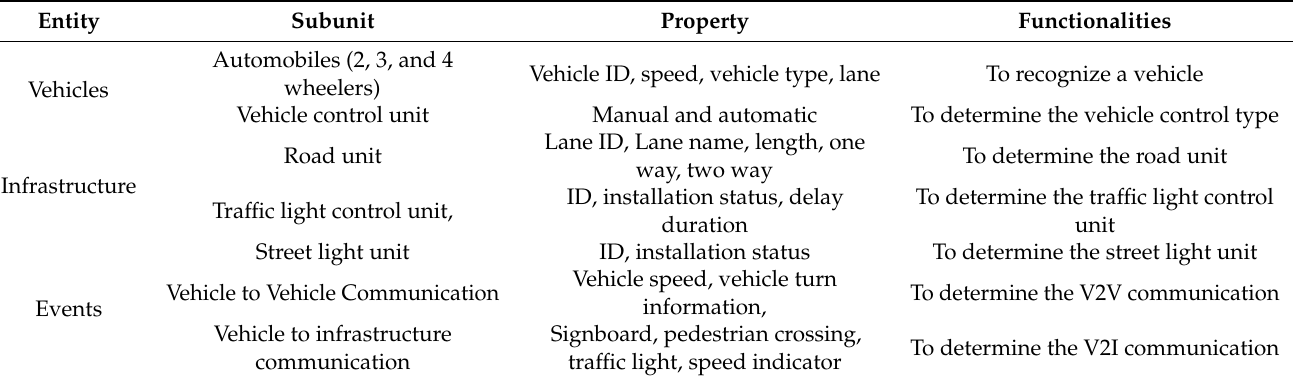
Table 2. Entities utilized in the proposed ATM system.